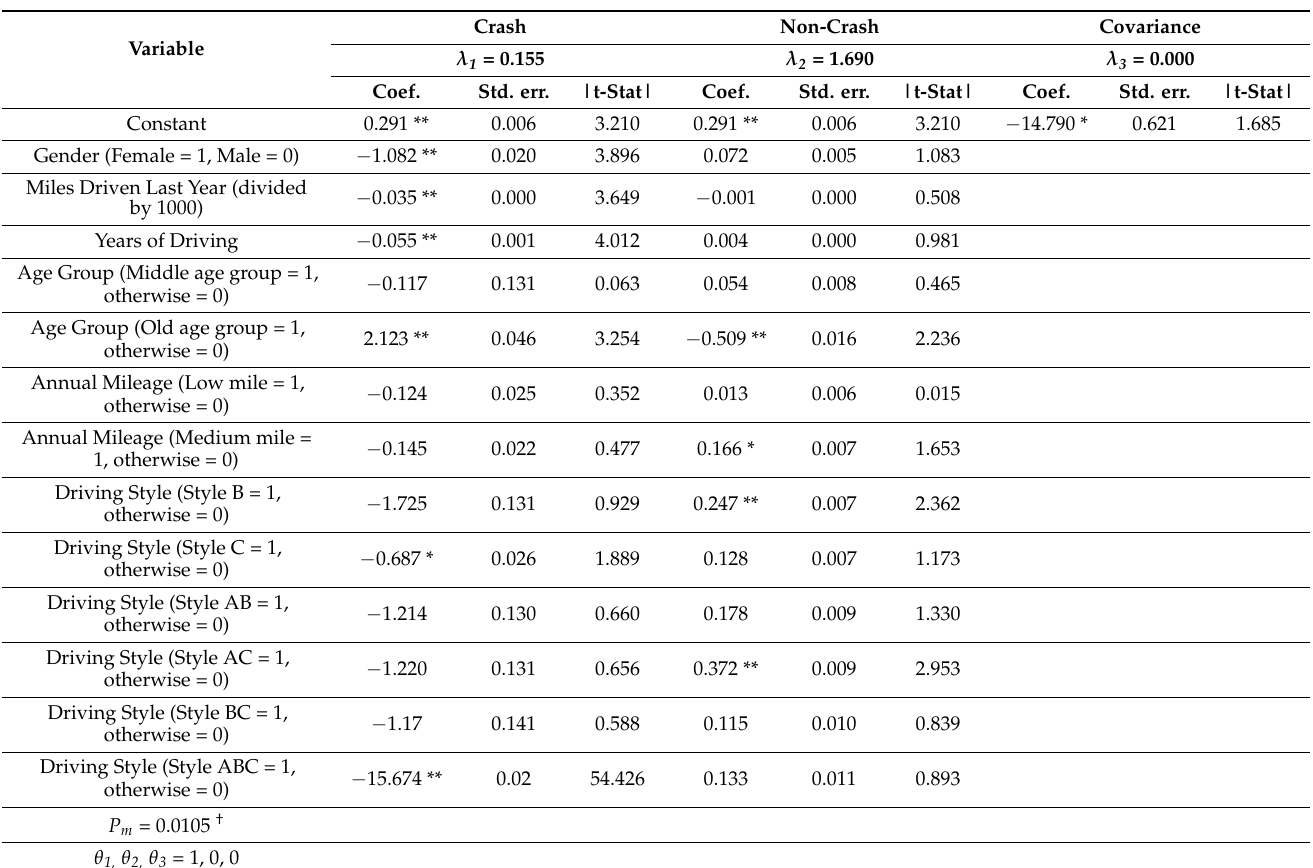
Table 7. DIBP Model estimation